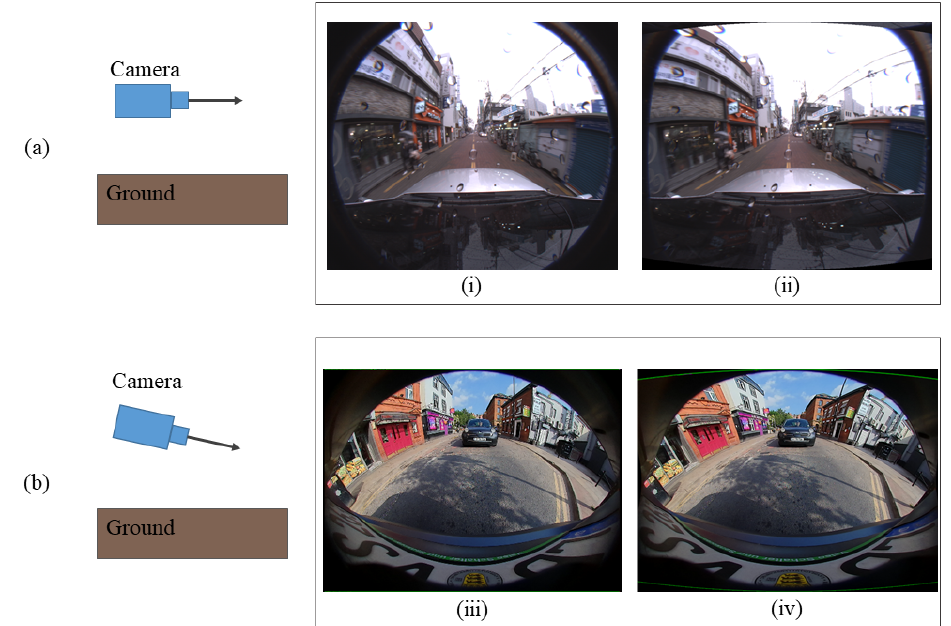
Figure 14. ( a ) Camera with a principal axis parallel to the ground from Fisheye-Dongseongro. ( b ) Camera looking downward from WoodScape. (i) and (iii) are the fisheye images and (ii) and (iv) are the spherically projected